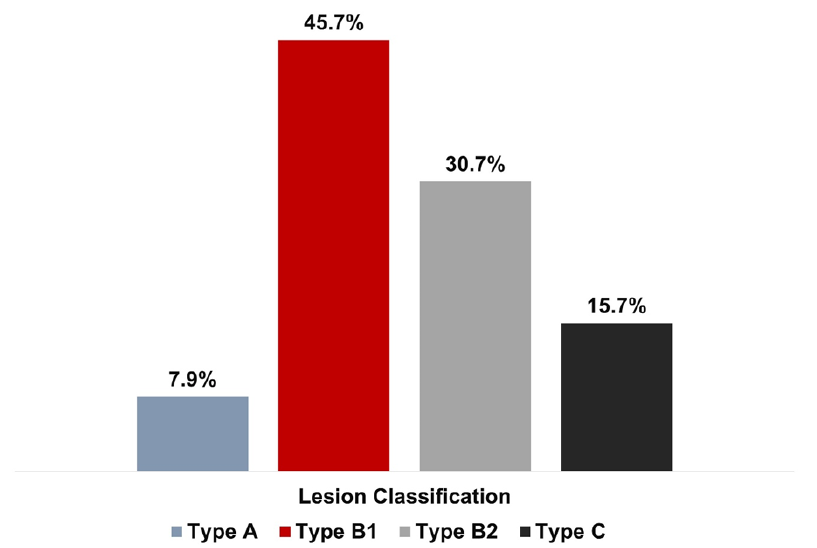
Figure 2. Lesion classification according to the modified American College of Cardiology/American Heart Association classification. Heart Association